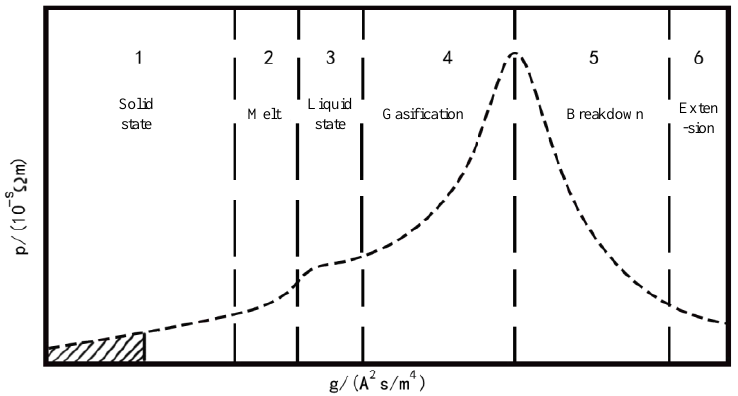
Figure 5. Control layer metal bridge electrical explosion process.